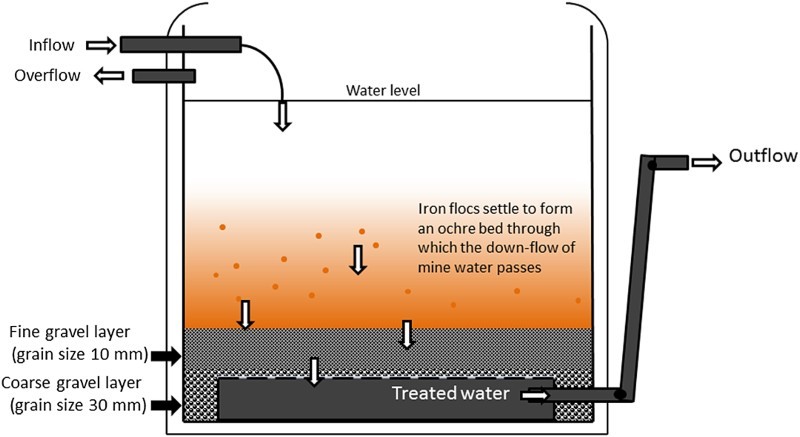
Conceptual diagram of the VFR field reactor (not to scale).